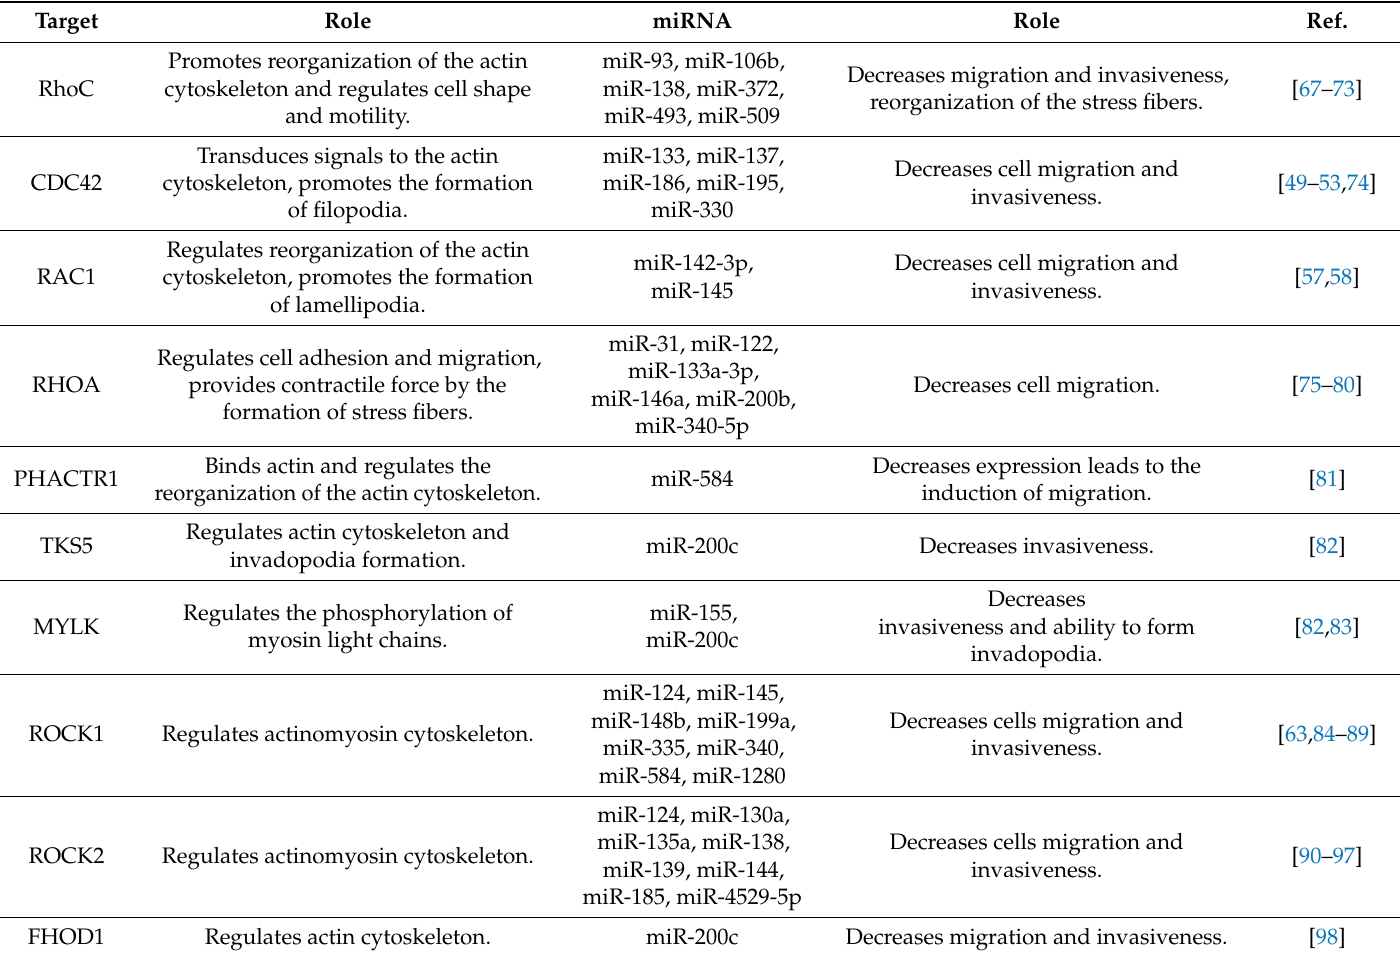
Table 2. Direct regulation of actin cytoskeleton by miRNAs in cancer